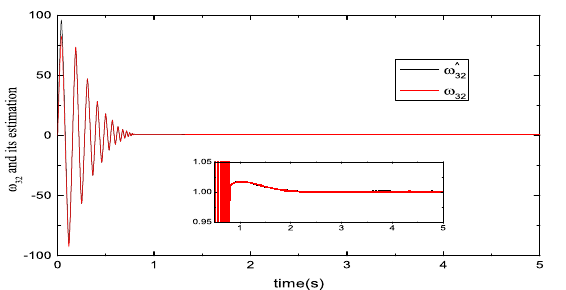
Figure 8. Estimated performance evaluation curves of four motor velocities: velocity ω 3 and its estimated value